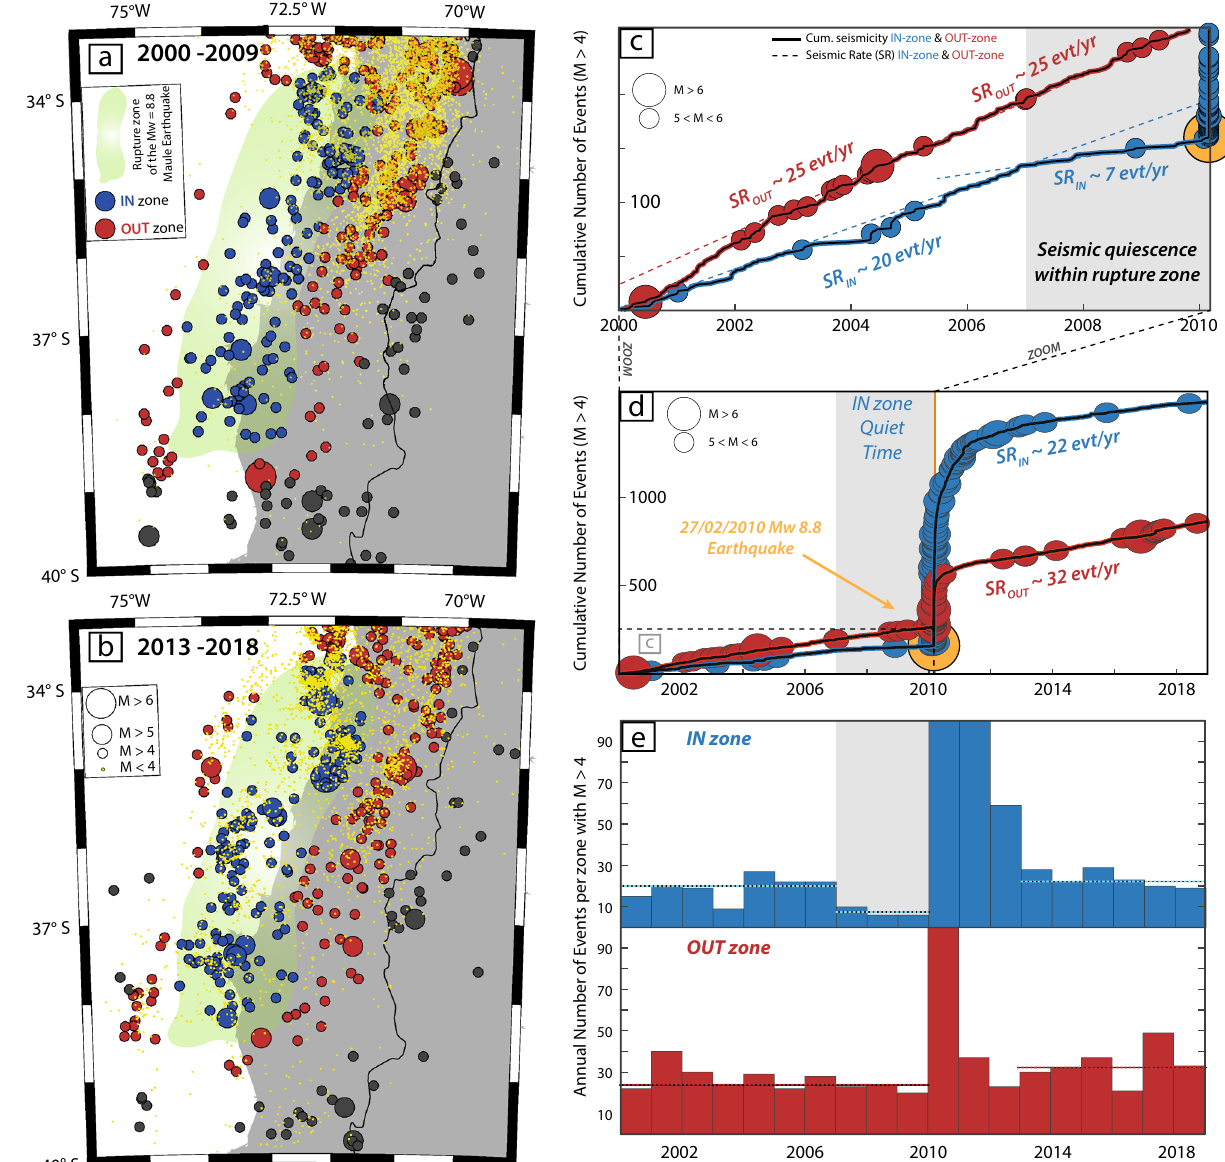
Figure 4. Seismic rate evolution of the 27F region before and after the main shock. Seismic activity recorded before ( a ) and after ( b ) the 27F event. The color code indicates the seismicity occurring within the coseismic zone (IN-zone, blue) and within the previously defined OUT-zone (red). Grey event are located outside both regions, and yellow dots correspond to the seismicity with M < 4. Both grey and yellow events are not taken into account for the seismic rate calculations. ( c–e ) Variations as a function of time of the cumulative number of events for both areas (IN-zone, blue curves) and the surrounding zone (OUT-zone, red curves). Only the events with M > 4 are considered. Dashed lines correspond to the observed seismic rates. ( c ) 2000–2010 pre-mainshock period. ( d ) Full 2000–2019 period. ( e ) Histograms of the seismic density in both IN and OUT